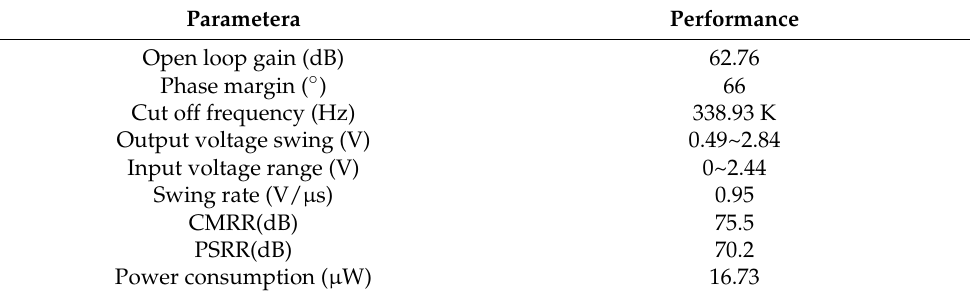
Table 1. Simulation results of pre stage operational amplifier.